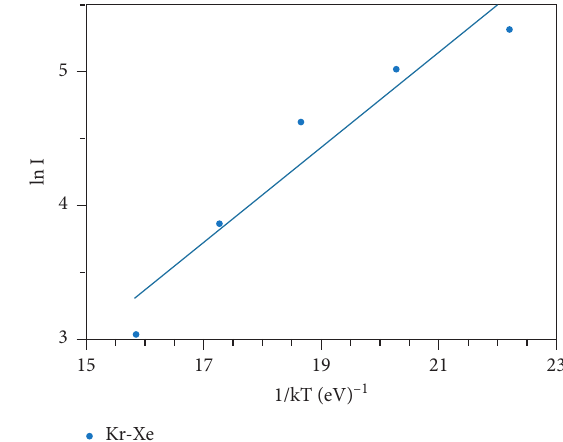
Figure 10: Dependence of the intensity of bands of heteronuclear ion molecules on the temperature of gas mixtures.